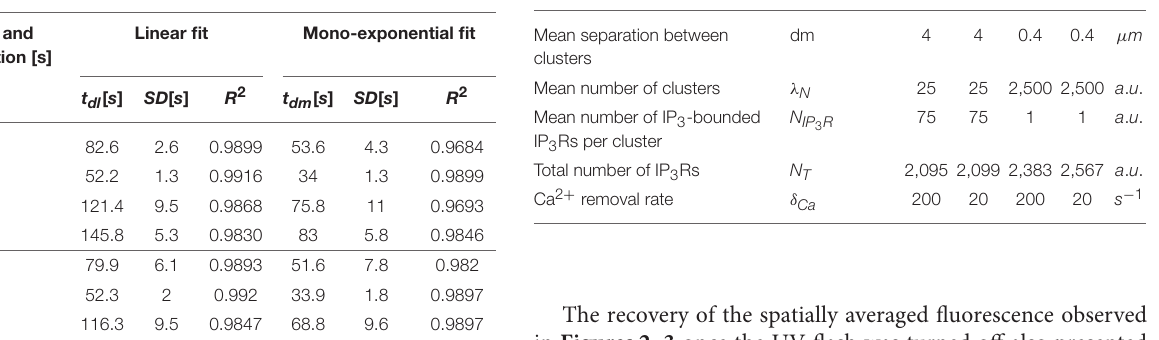
TABLE 2 | Similar to Table 1 , but for the parameters derived from the linear (Equation 6) and the mono-exponential (Equation 5) fits of the decaying part of the fluorescence, F k ( t ) (Equation 1), observed in eggs.